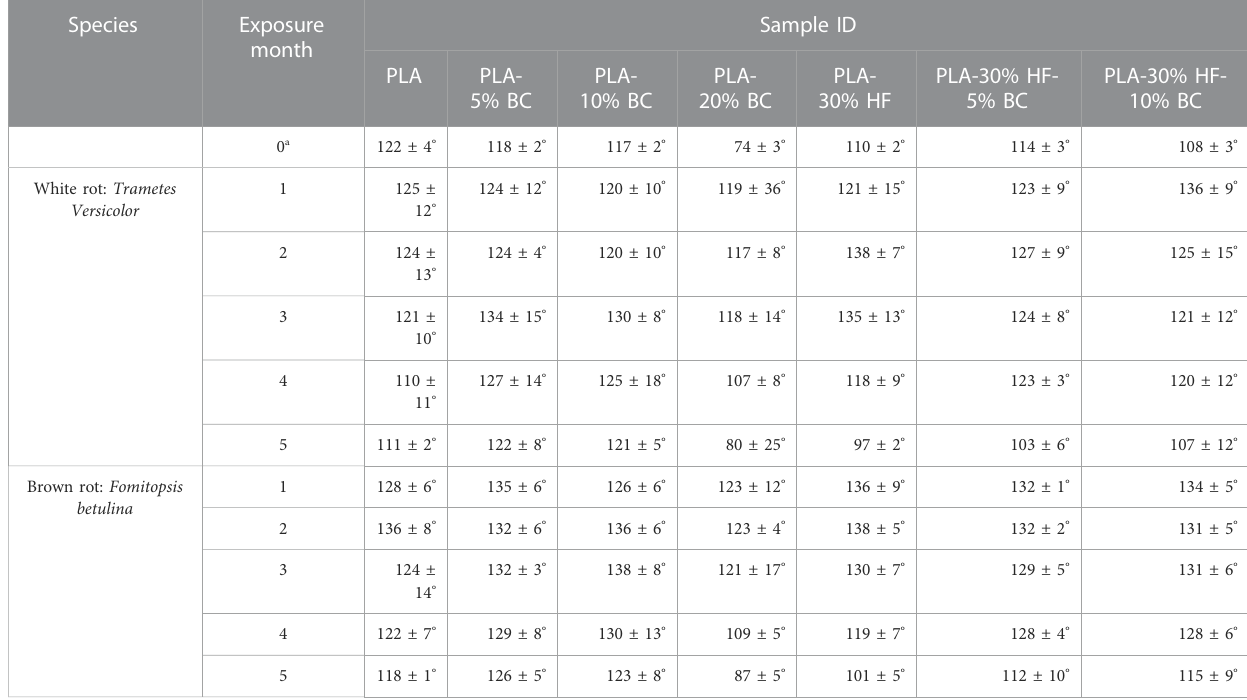
TABLE 1 Average water contact angle results of the composites during exposure to fungi.